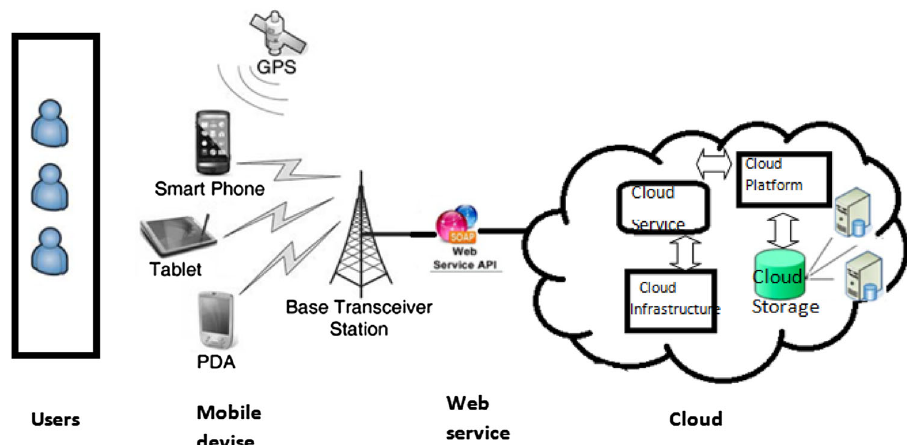
Fig. 2 Mobile cloud computing